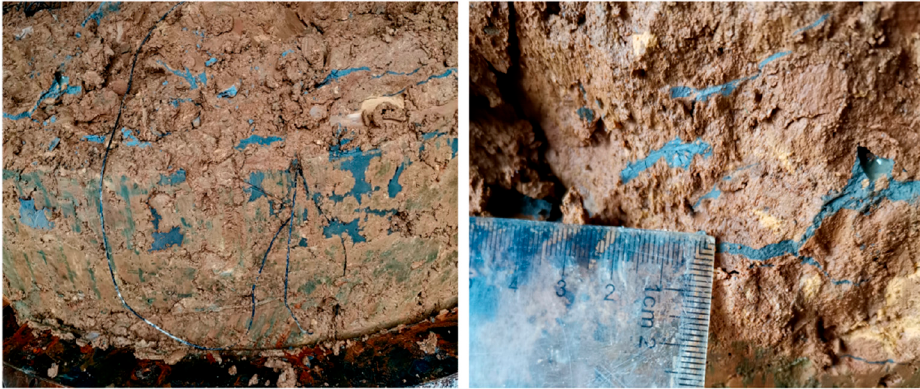
Figure 12. Distribution of permeable filling grouting veins.